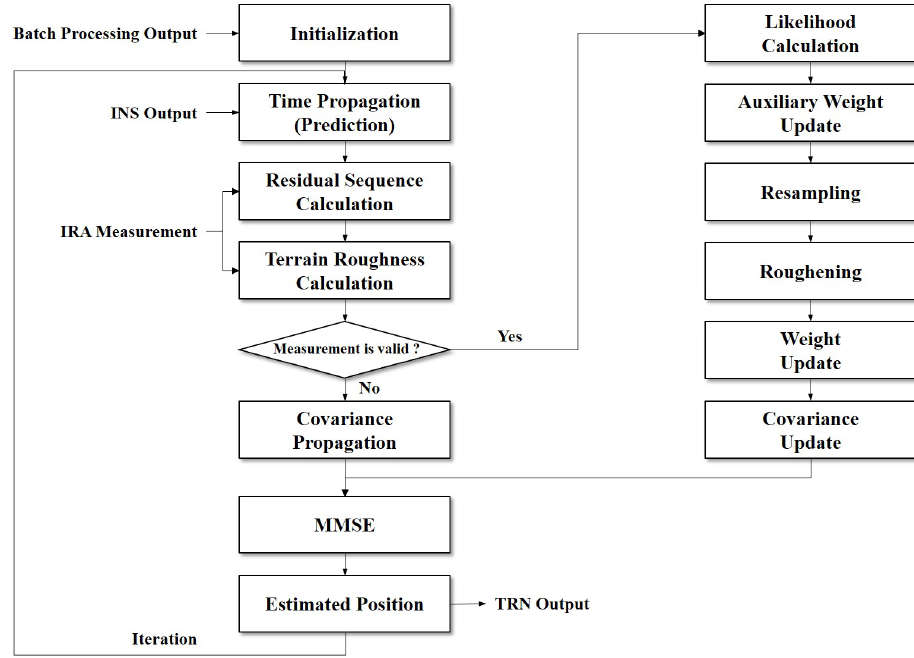
Figure 4. Execution flowchart of the auxiliary particle filter (APF)-based TRN